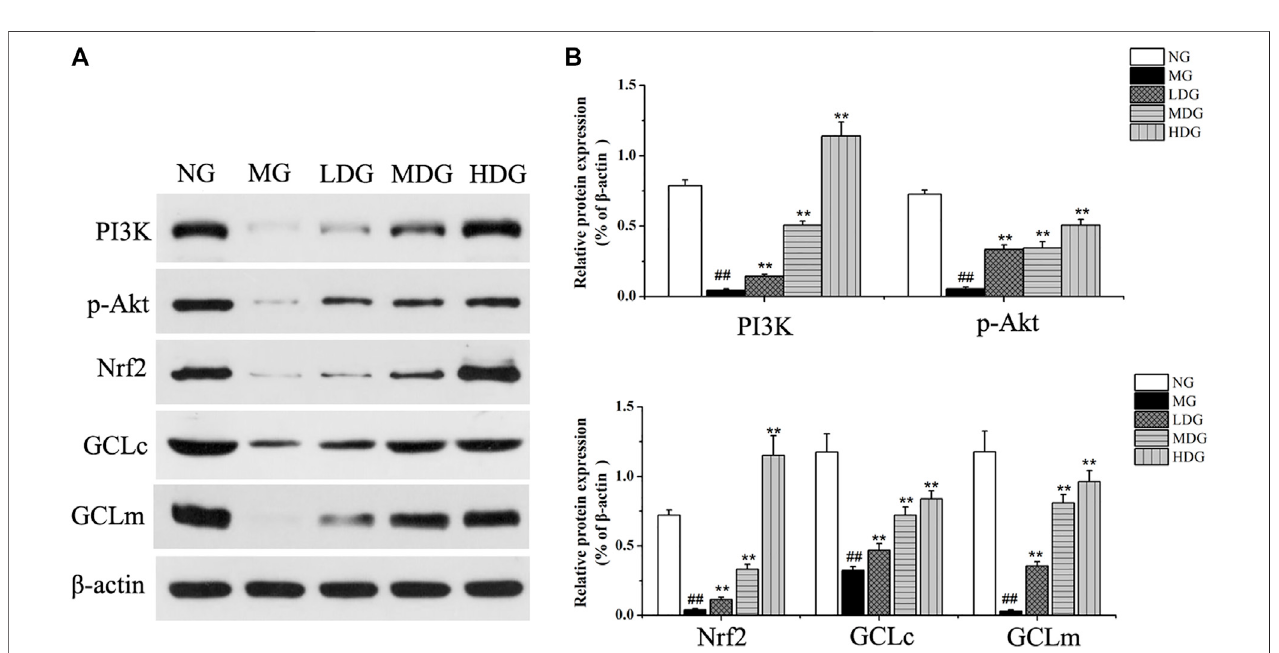
FIGURE 10| The effects of HGJD on the expression ofPI3K/Akt/Nrf2 signaling pathway. The effect of HGJD pretreatment on PI3K p-Akt, Nrf2, GCLc, and GCLm protein expression after ANIT treatment (A) and the optical density analysis of the protein bands intensity (B) . Data are expressed as the mean ± SD, ## p < 0.01 contrasted with the normal group. ** p < 0.01 contrasted with the model